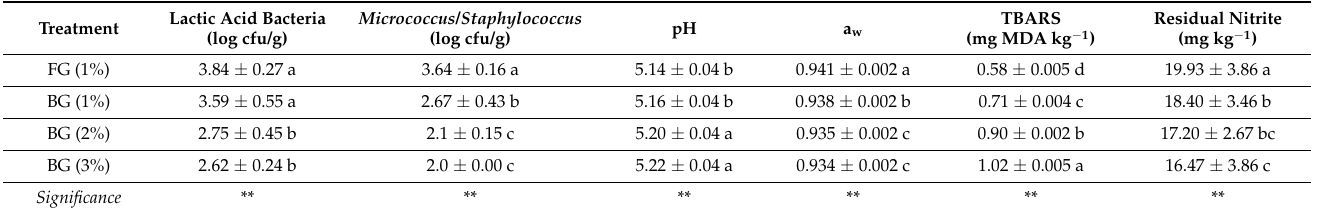
Table 1. The overall effect of garlic treatment on the microbiological counts, pH, a w , TBARS and residual nitrite of heat-treated sucuk (mean ± sd).